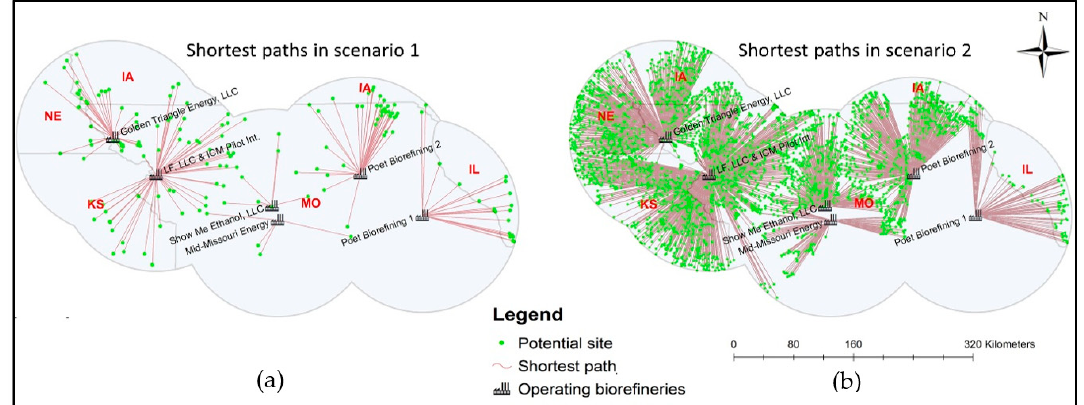
Figure 5. The shortest path from existing biorefinery plants to potential switchgrass cultivation locations ( a ) in scenario 1 and ( b ) in scenario 2. The refineries are connected to their potential incidents, which would serve as sources of biomass. Table 6. Potential feedstock by biorefinery in scenario 1.